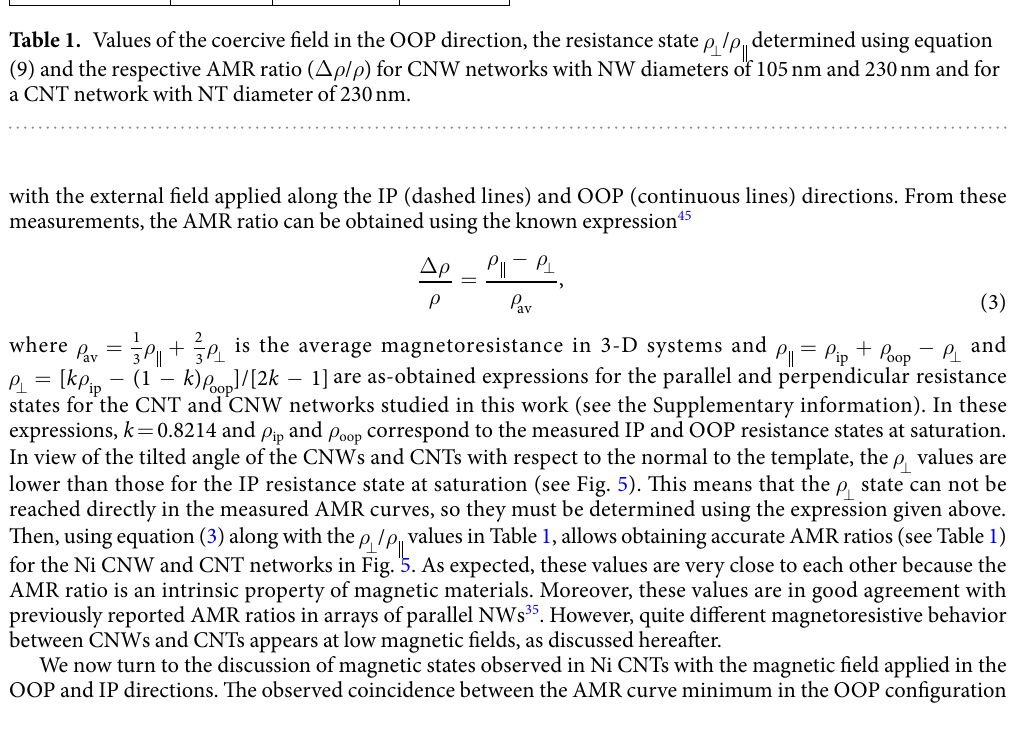
/ ρ determined using equation ⊥